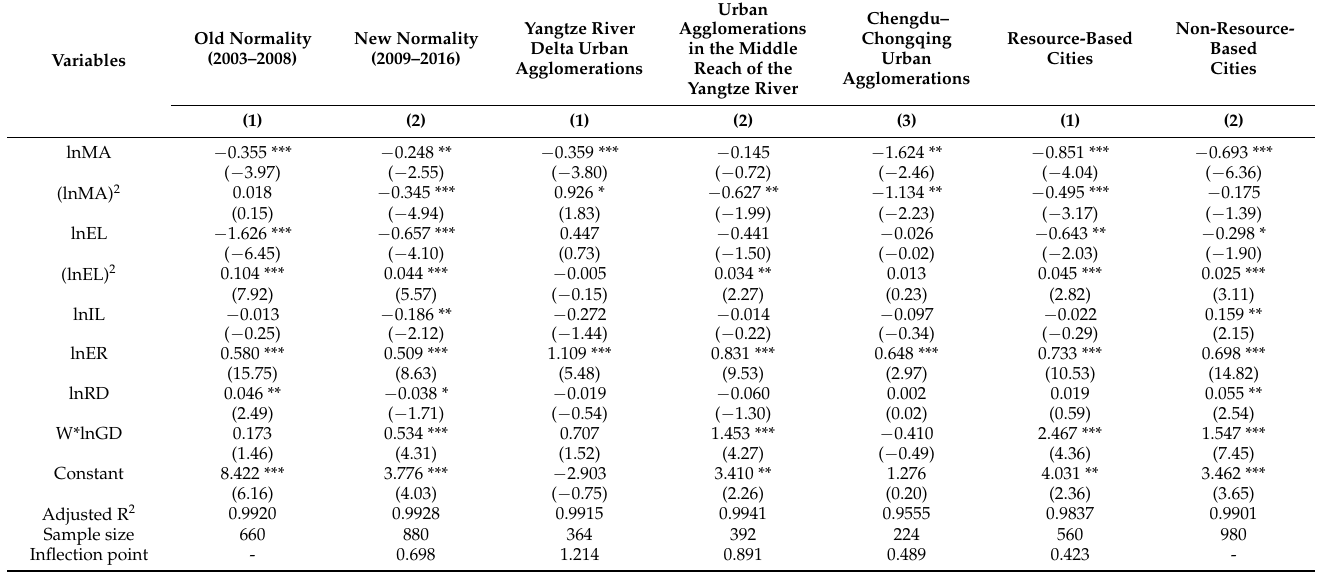
Table 4. Results of heterogeneity